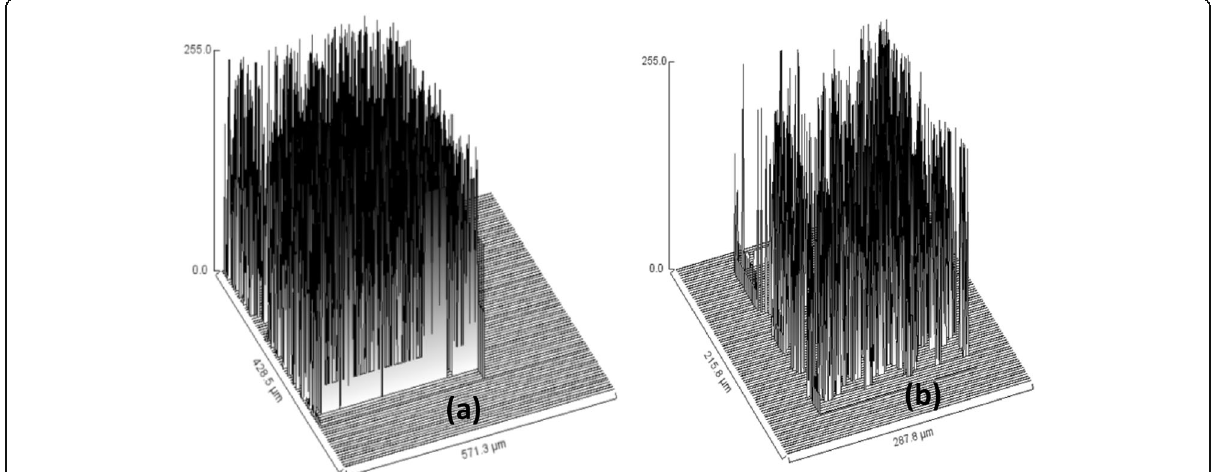
Fig. 6 3-D plots showing arrangement of particles on the surface of Moringa oleifera ( a ) and Ficus exasperata ( b ). Surface of the FE-AgNPs presents evidence of larger pore